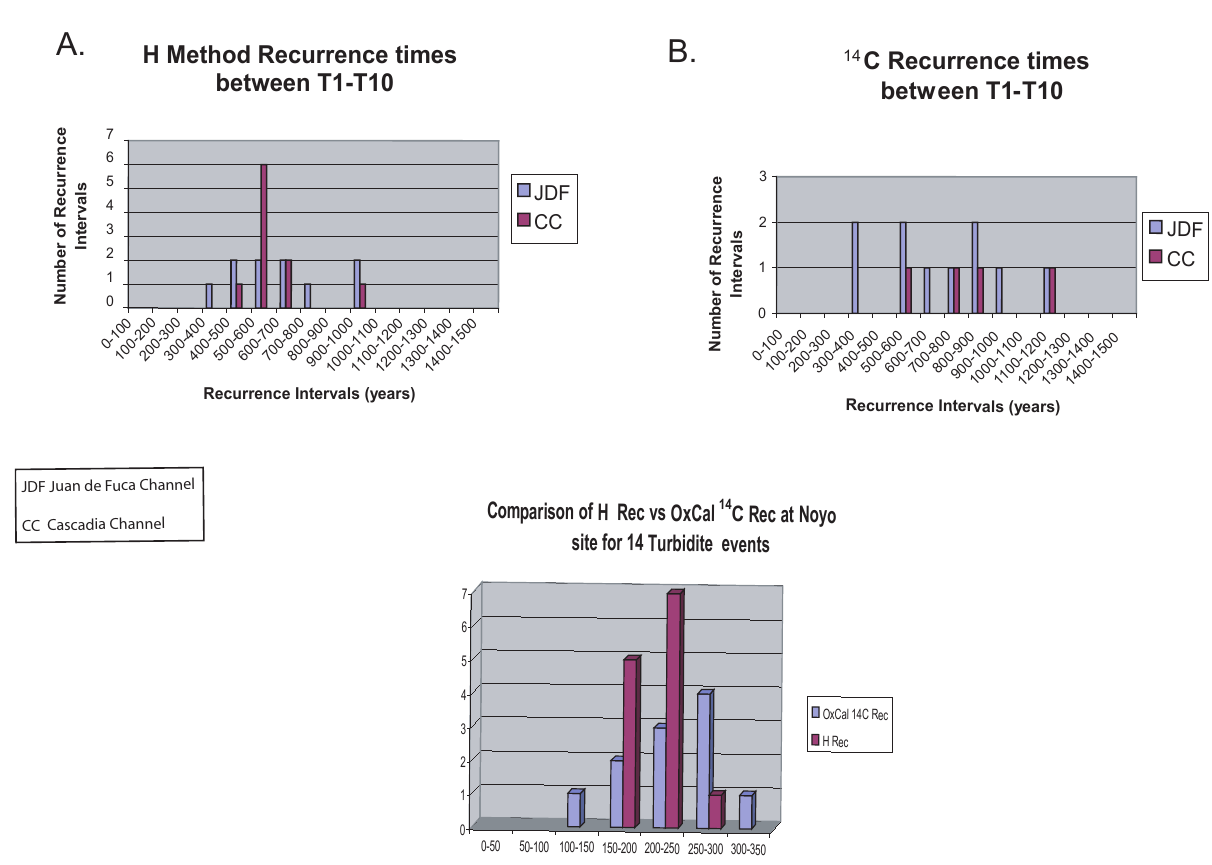
Fig. 7. (A) and (B) comparison of the frequency distribution of recurrences times from T1 to T10 turbidite events in Juan de Fuca (JDF) and Cascadia Channel (CC). Histogram (A) is based on hemipelagic sediment thickness (H Rec), and histogram (B) is based on AMS radiocarbon ages ( 14 C). Histograms show the number of recurrence times observed in each 100yr interval class (e.g. 0–100yr, 100–200yr) at each site shown in the figure. Note that the maximum ( ∼ 1100 to 1300yr) and minimum ( ∼ 300yr) recurrence times are similar for 14 C and hemipelagic sediment thickness, but both extremes are more frequent for the 14 C dataset. Comparing both (A) and (B) histograms, we can infer that data show a major mode of recurrence times from 500 to 600yr and a normal distribution of times, whereas the 14 C recurrence times are more broadly distributed. (C) Histogram showing the distribution of turbidite recurrence frequencies at Noyo Channel for the first 14 turbidite events based on 14 C ages obtained with the OxCal software and on hemipelagic sediment thickness (H Rec). We can infer that data show a major mode of recurrence times from 200 to 250yr. Note that the H recurrence bars (H Rec) show a more normal distribution than the OxCal recurrence bars (OxCal 14 C Rec), with maximum recurrence times of ∼ 250yr and minimum times of ∼ 150yr. (Figure is modified from Guti´errez Pastor et al.,